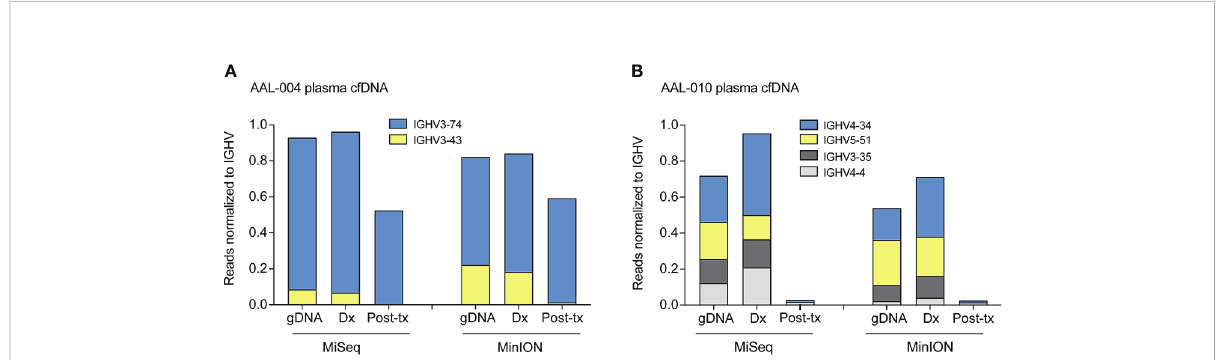
FIGURE 3 Comparison of clone distribution between Illumina and Nanopore MinION sequencing platforms. IGHV PCR of select time points from patients AAL-004 (A) and AAL-010 (B) was divided and sequenced with MinION (nanopore) or MiSeq (Illumina). V-region clones comprising more than 5% of the total clones in the sample taken at diagnosis were tracked across the two later time points and normalized to the total number of reads aligned to Chr14 per sample. Clone distribution across different time points within each patient is uniform regardless of the sequencing platform. Dx: sample taken at B-ALL diagnosis, post-tx: sample taken